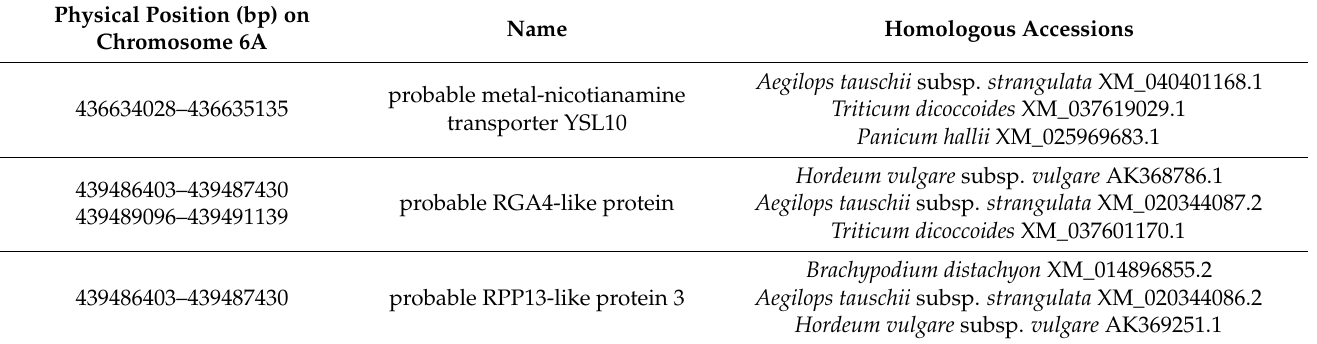
Table 5. Detailed information on predicted genes within the region where Pc50-5 was mapped to oat reference genome ( Avena sativa -OT3098 v2, PepsiCo) [27].